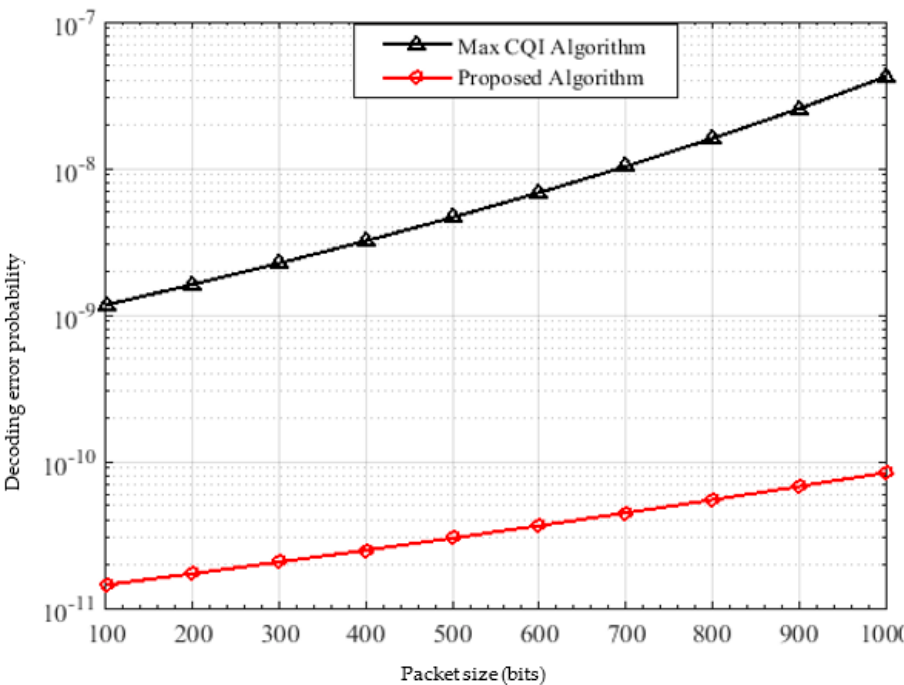
Figure 11. Decoding error probability versus the packet size.